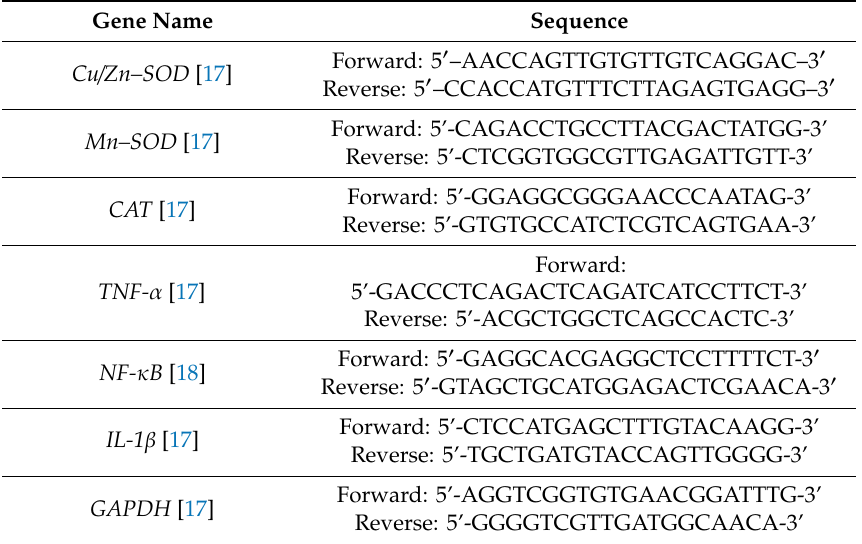
Table 2. Sequences of the primers used for the mice liver